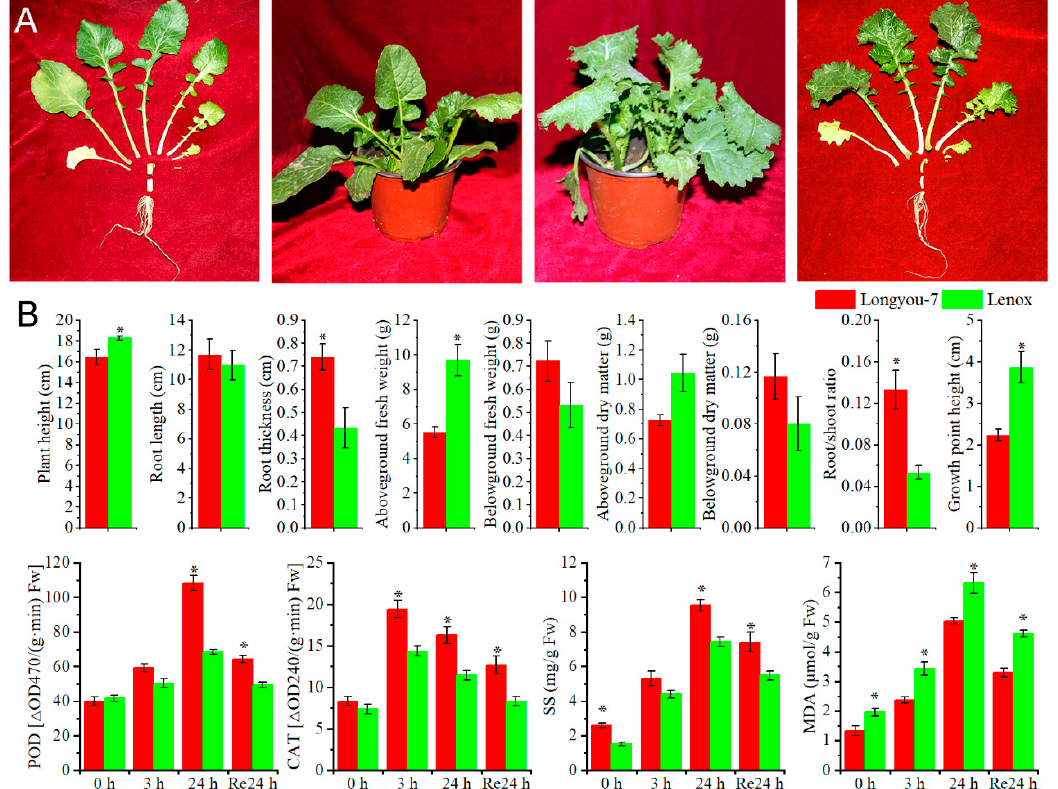
Figure 1. Plant growth, morphological, and physiological indicators. ( A ) Growth characteristics of Longyou-7 and Lenox under cold stress at 4 °C; ( B ) Morphological and physiological indicators of Longyou-7 and Lenox under cold stress at 4 °C. Error bars denote standard error of the mean. Significant differences between varieties at p ≤ 0.05 are denoted by an asterisk. Abbreviations: CAT: Catalase, MDA Malondialdehyde, POD Peroxidase, SS Soluble sugar.